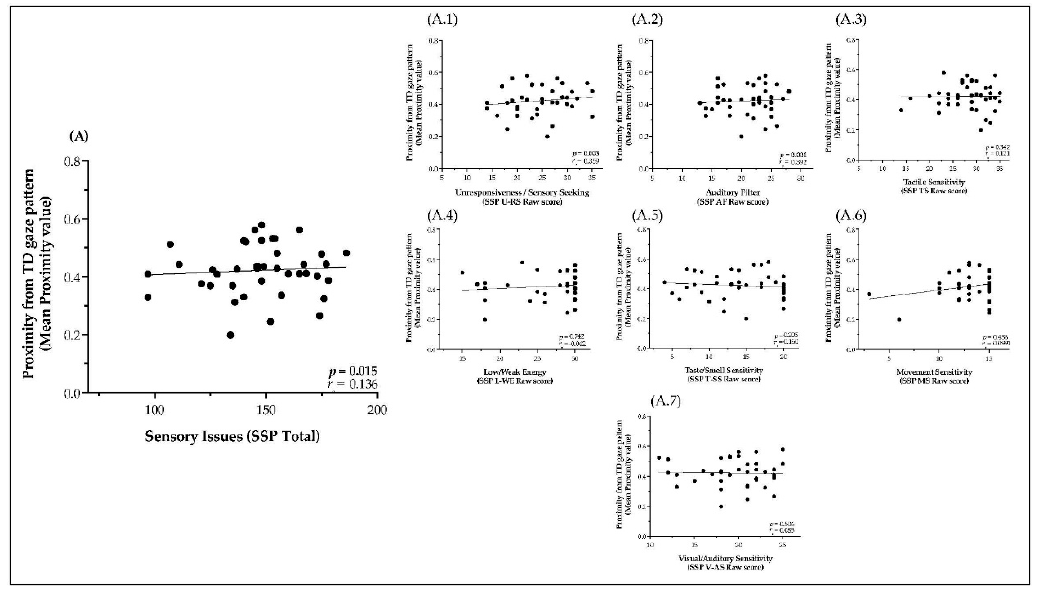
Figure 4. Correlations between Proximity value with: ( A ) Sensory issues (SSP Total score); ( A.1–7 ) All seven modalities of the SSP (Raw score) in the ASD group across all three Social Scenes (Tickles, Drink and Pointing scene).